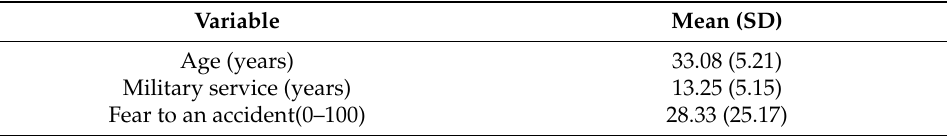
Table 1. Characteristics of military